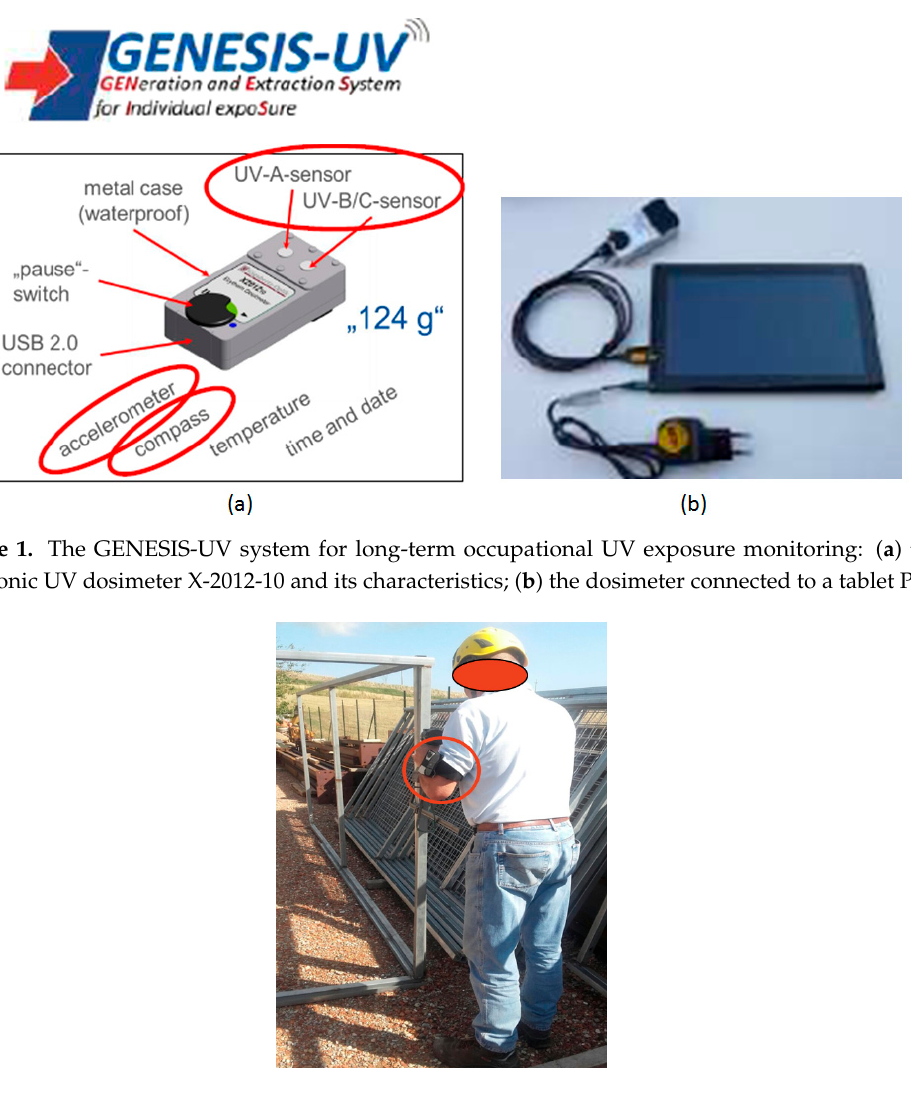
Figure 2. A construction worker in Tuscany wearing the GENESIS-UV dosimeter on the upper left arm.